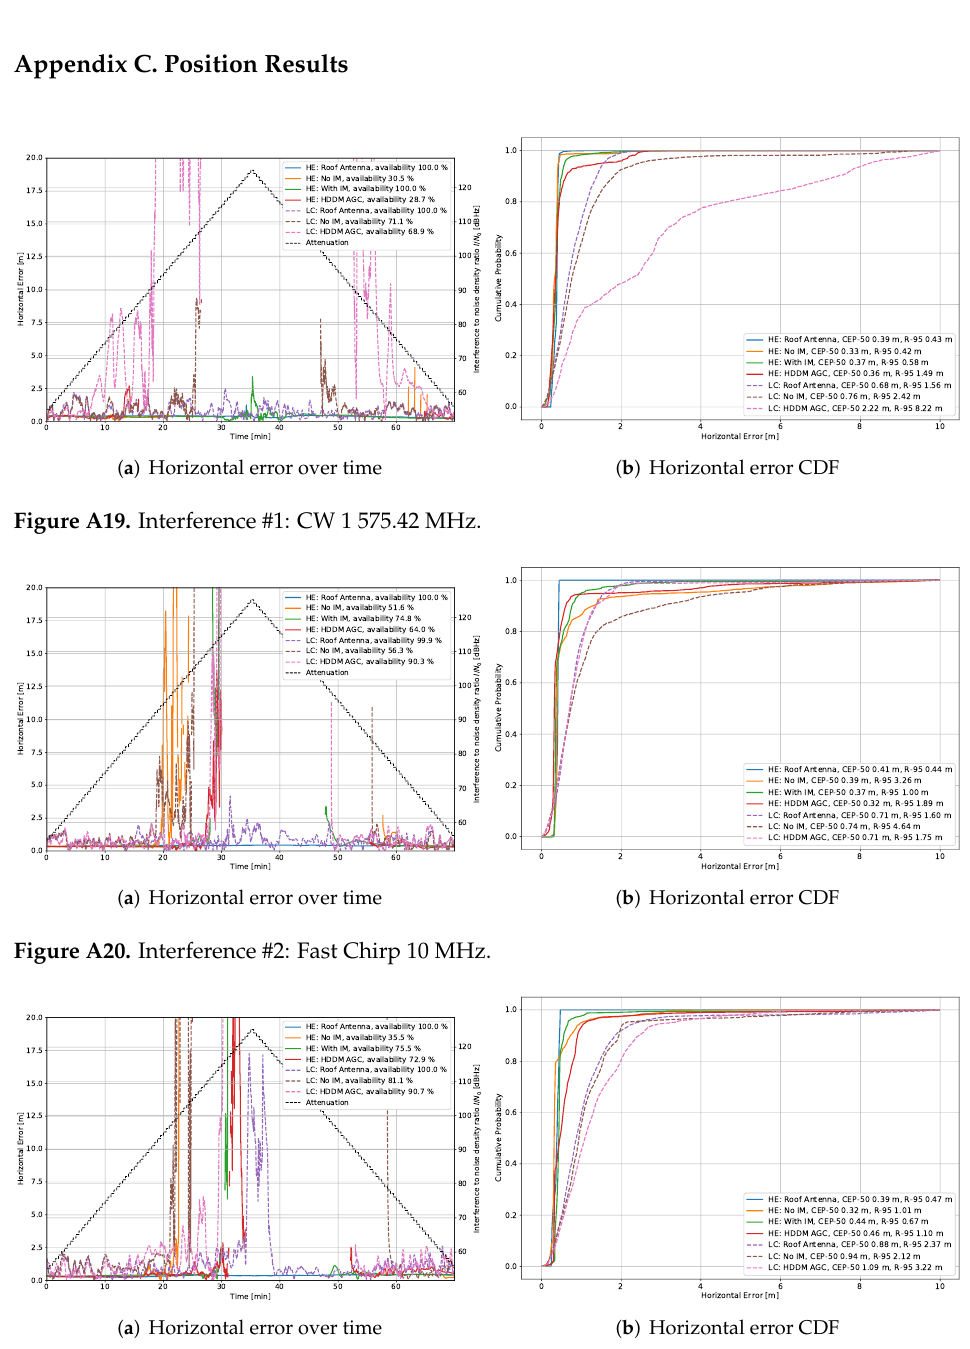
Figure A21. Interference #3: Slow Chirp 10